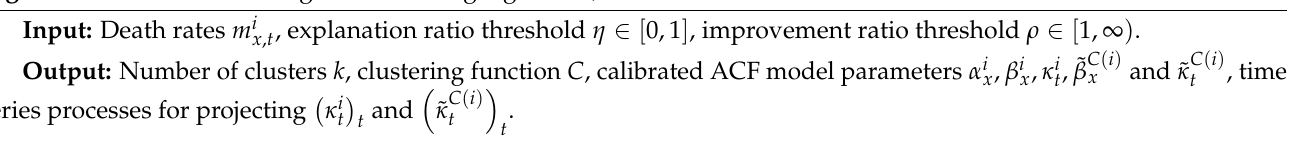
Algorithm A1 The ACF fitting and clustering algorithm, see Section